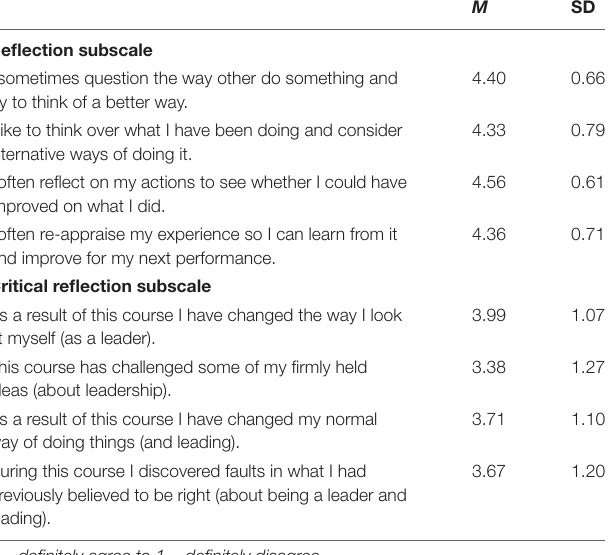
TABLE 4 | Course evaluation ratings for NFHS captain’s leadership course.